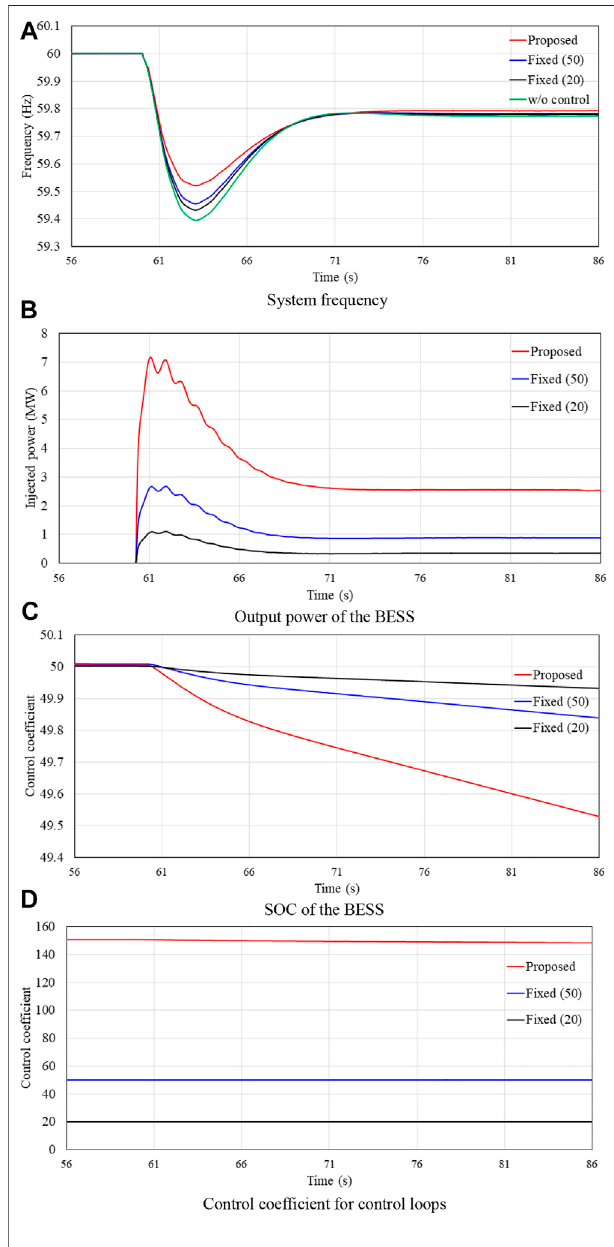
FIGURE 6 | Results for case 1. (A) System frequency. (B) Output power of the BESS. (C) SOC of the BESS. (D) Control coef fi cient for control loops.